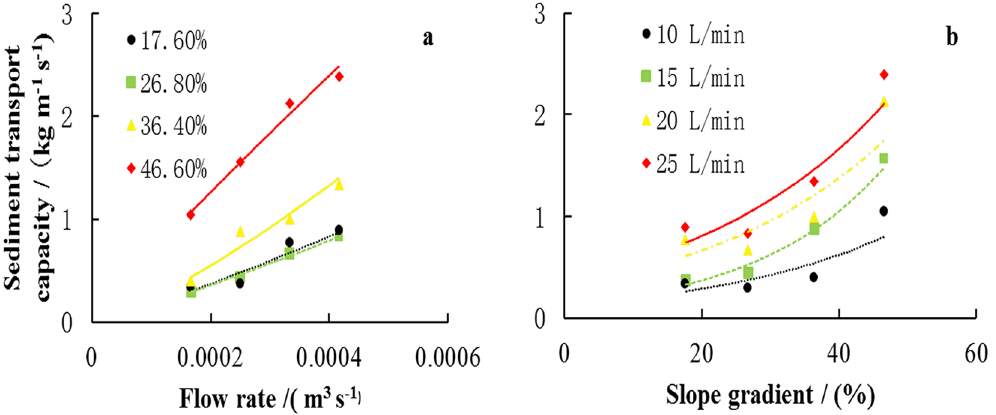
Figure 2. Relationships between sediment transport capacity and: ( a ) flow rate; ( b ) slope